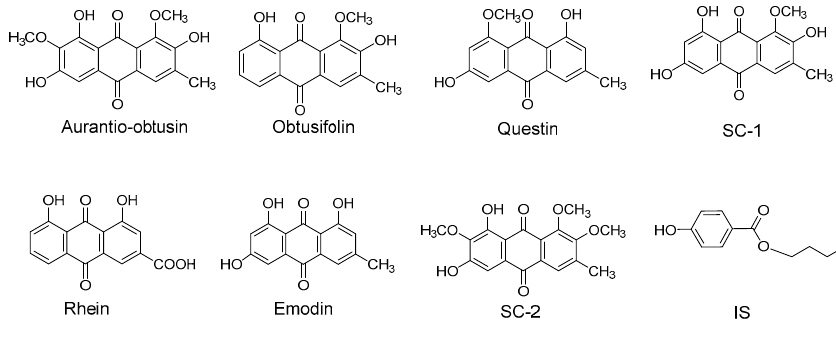
Figure 1. Chemical structures of seven analytes and internal standard.